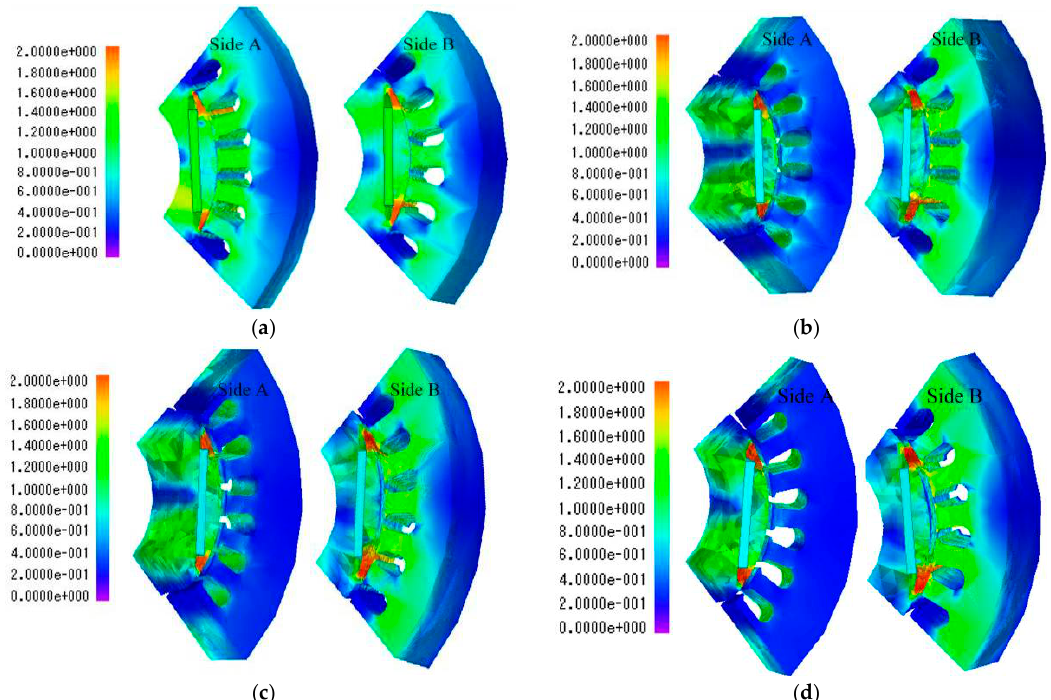
Figure 8. 3-D FE results with different CR axial displacement: ( a ) Flux density at ∆ z = 0, ( b ) Flux density at ∆ z = 1.5 mm, ( c ) Flux density at ∆ z = 3.0 mm, ( d ) Flux density at ∆ z = 4 mm.